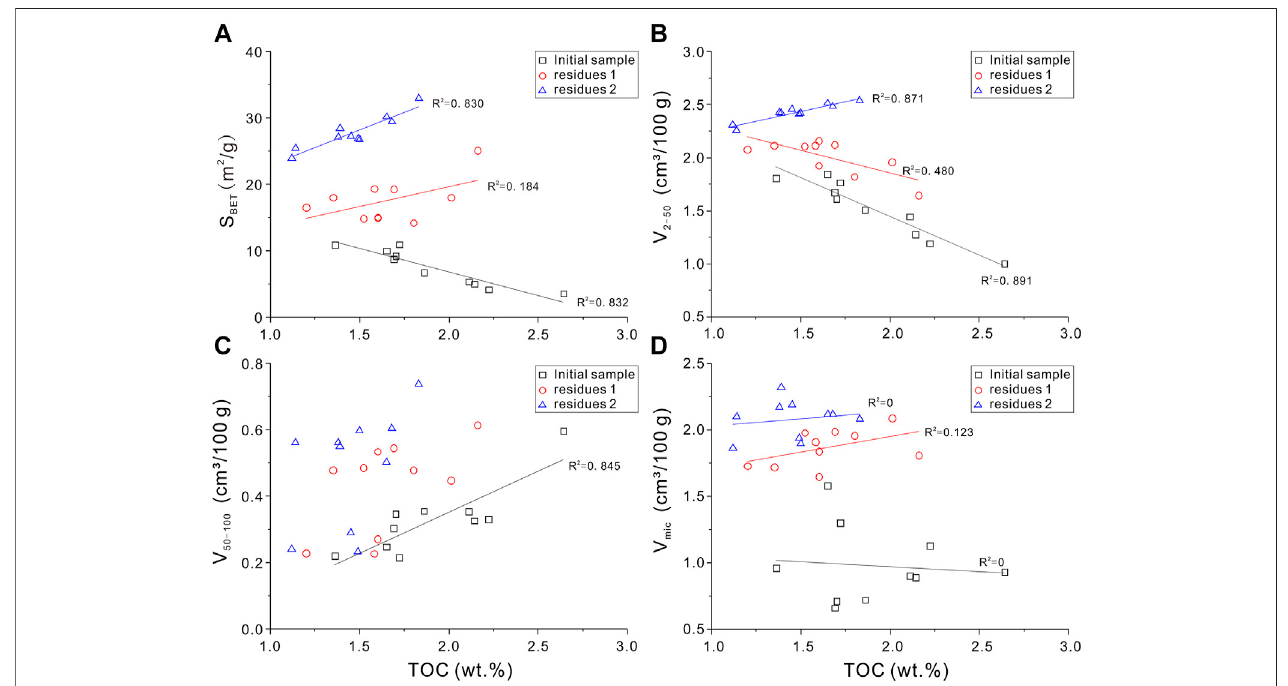
FIGURE 7 | Correlation of pore surface areas and pore volumes with the TOC.